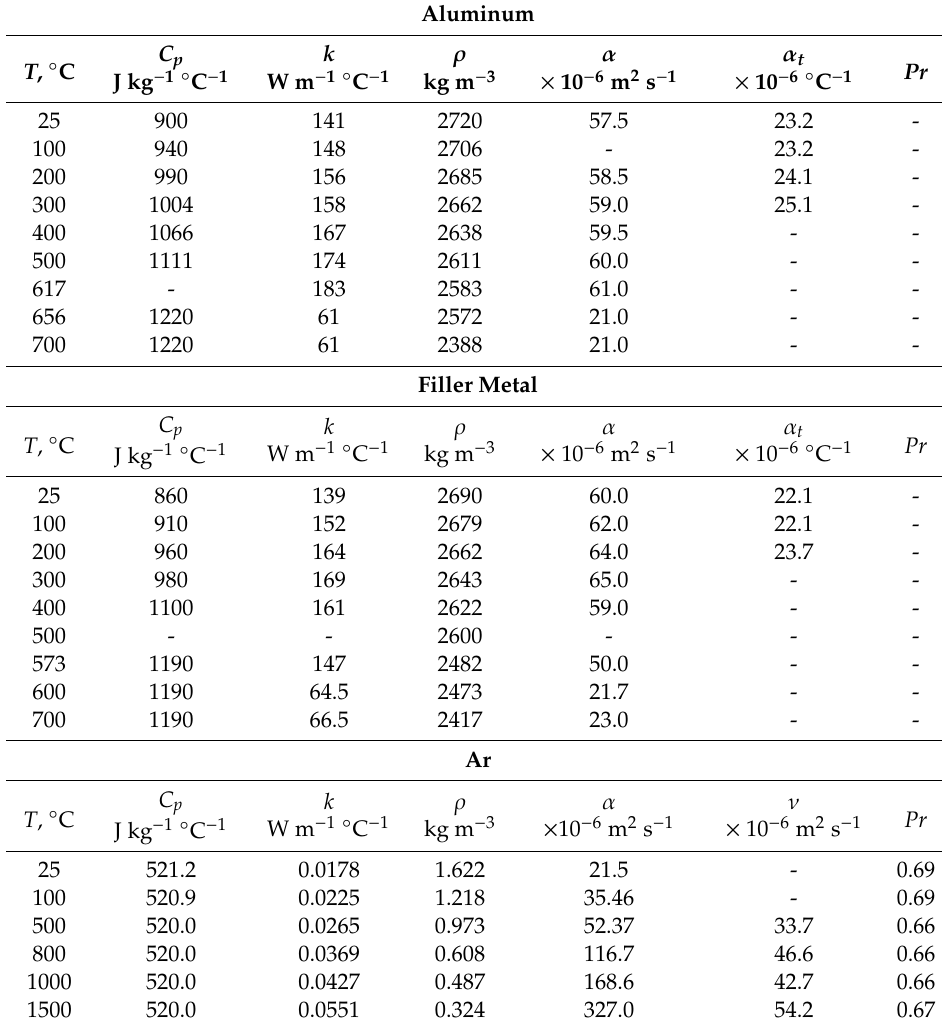
Table 2. Thermophysical properties used for the finite element analysis